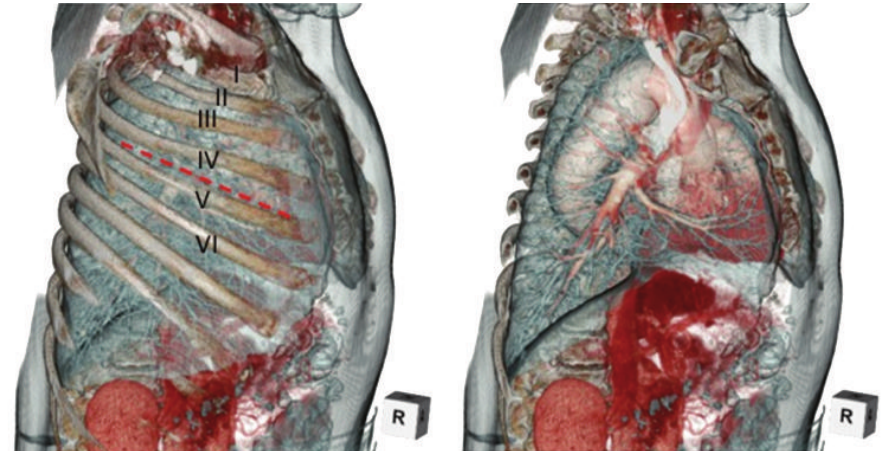
Figure 2: 3D-CT imaging, scrolling from superficial to deep layer view with chest wall including the ribs, showed the surgical view and the optimal approach through a posterolateral thoracotomy with the fourth intercostal